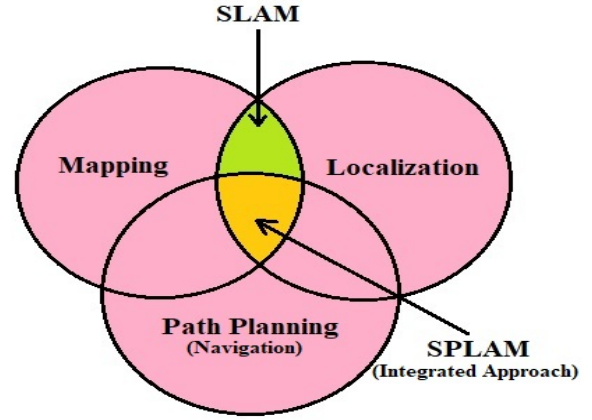
Figure 9. Interactions of activities of autonomous navigation of mobile robots.